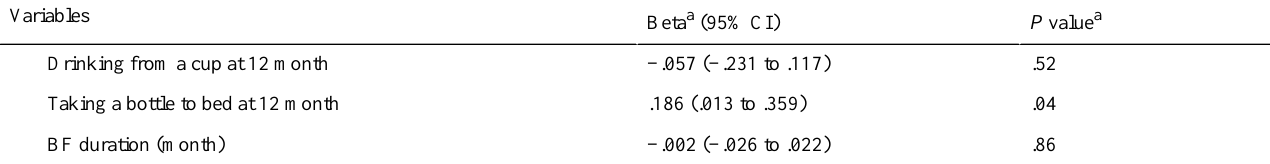
a Multiple linear regression: The number of participants with both infant feeding practice data at 12 months and BMI data at 24 months was 359 in total, 197 from the intervention group, and 162 from the control group.